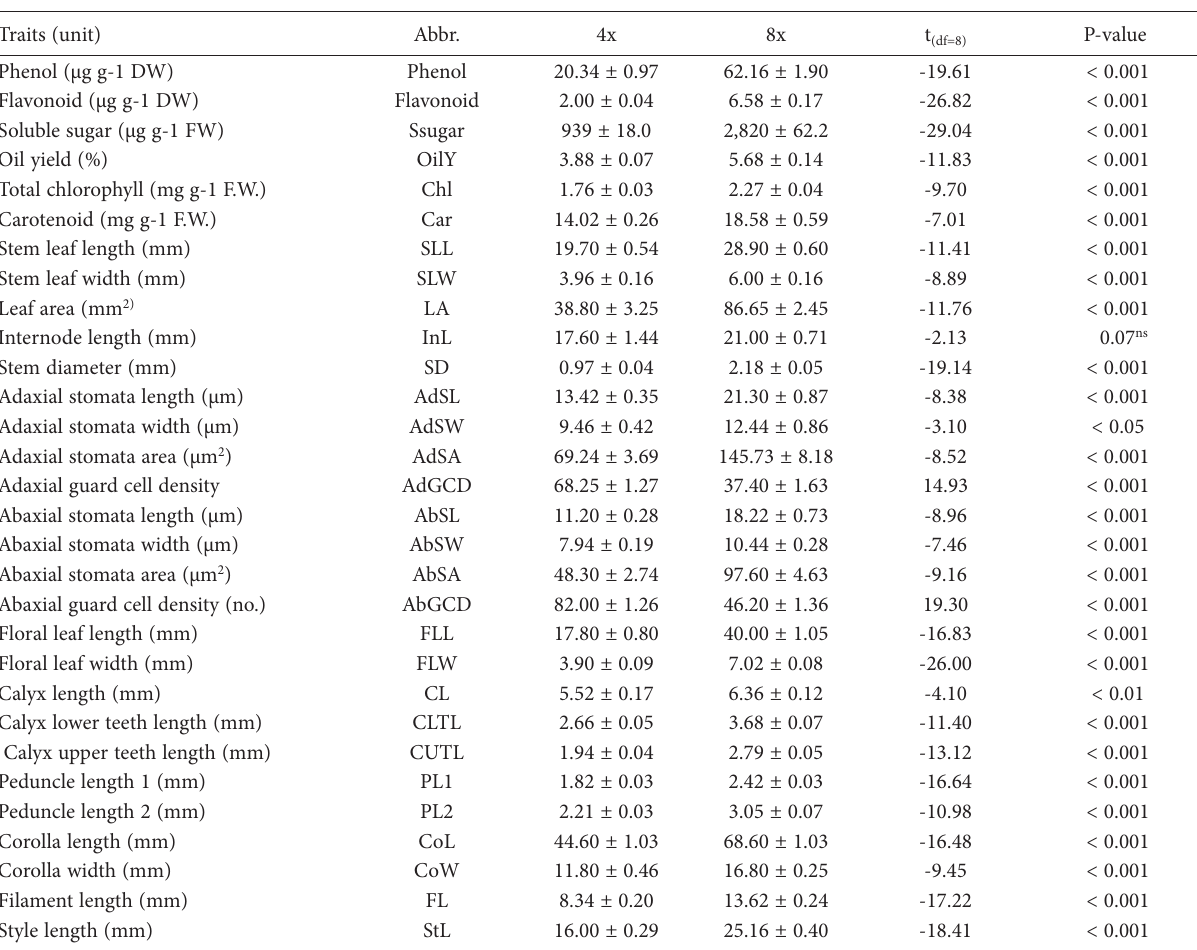
Table 3. Effects of induced polyploidy on physiological and anatomical characteristics of Satureja mutica . Reported values are mean ± S.E., P-values based on t-test for independent samples (n =